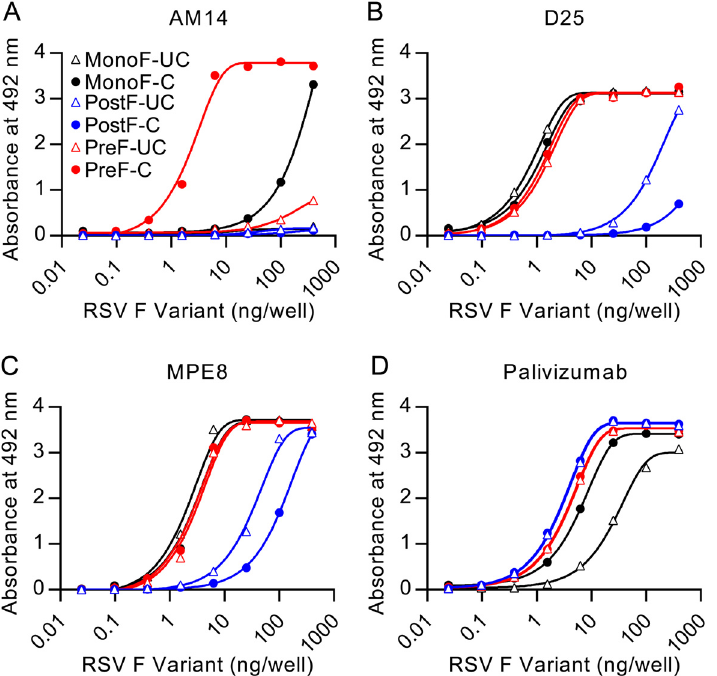
Fig 4. AM14 is specific for cleaved, trimeric RSV F. Binding of antibodies (A) AM14, (B) D25, (C) MPE8, or (D) palivizumab to uncleaved monomeric RSV F (open black triangles), cleaved monomeric RSV F (black circles), uncleaved postfusion RSV F (open blue triangles), cleaved postfusion RSV F (blue circles), uncleaved prefusion RSV F (open red triangles) and cleaved prefusion RSV F (red circles) was measured by